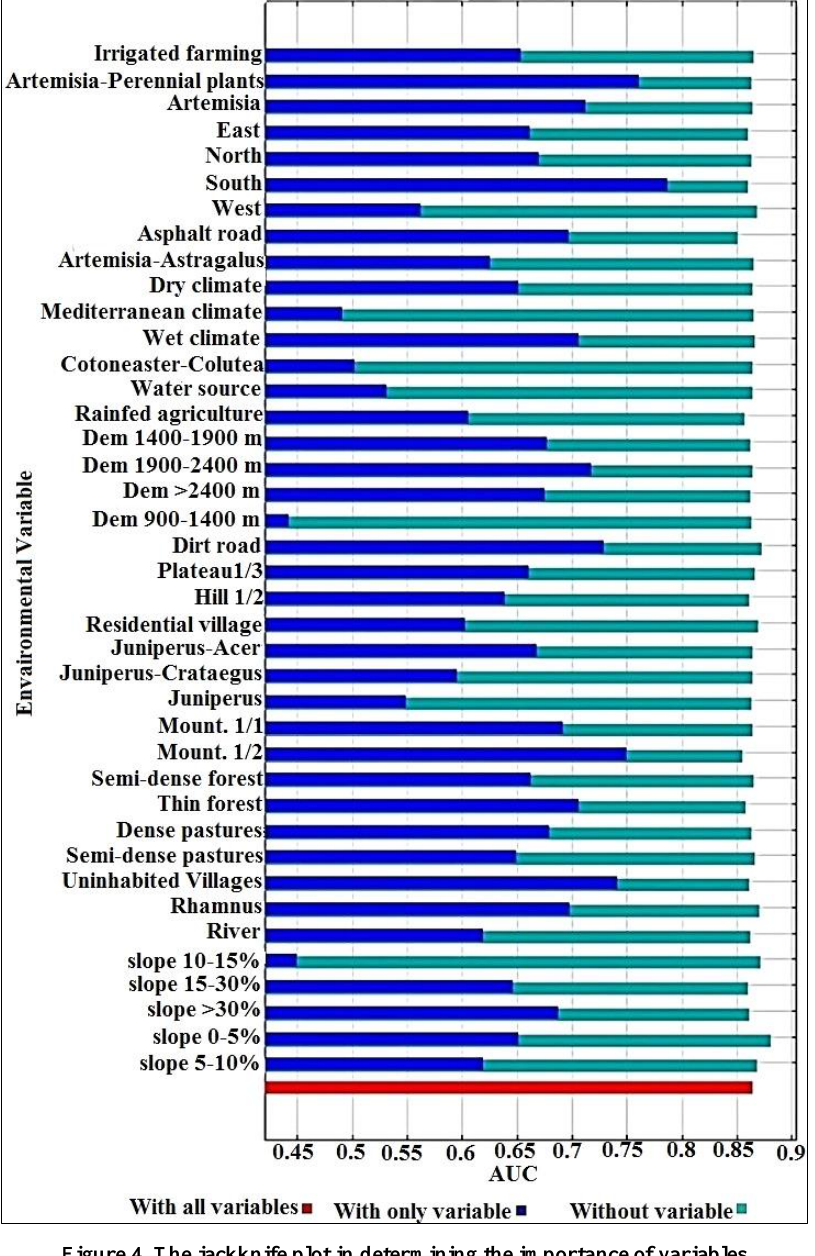
Figure 4. The jackknife plot in determining the importance of